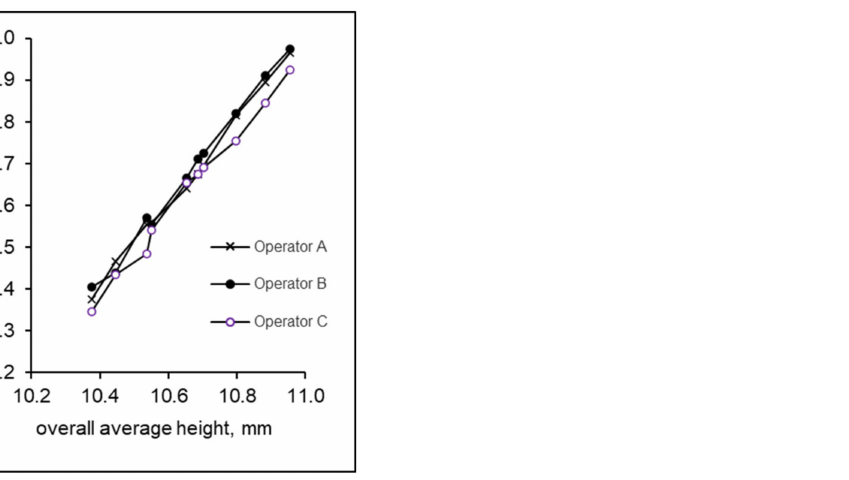
Figure 7. Stacked average chart (interaction plot).